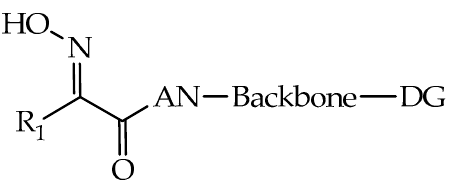
Figure 17. Representation of the general formula of oxime [90].